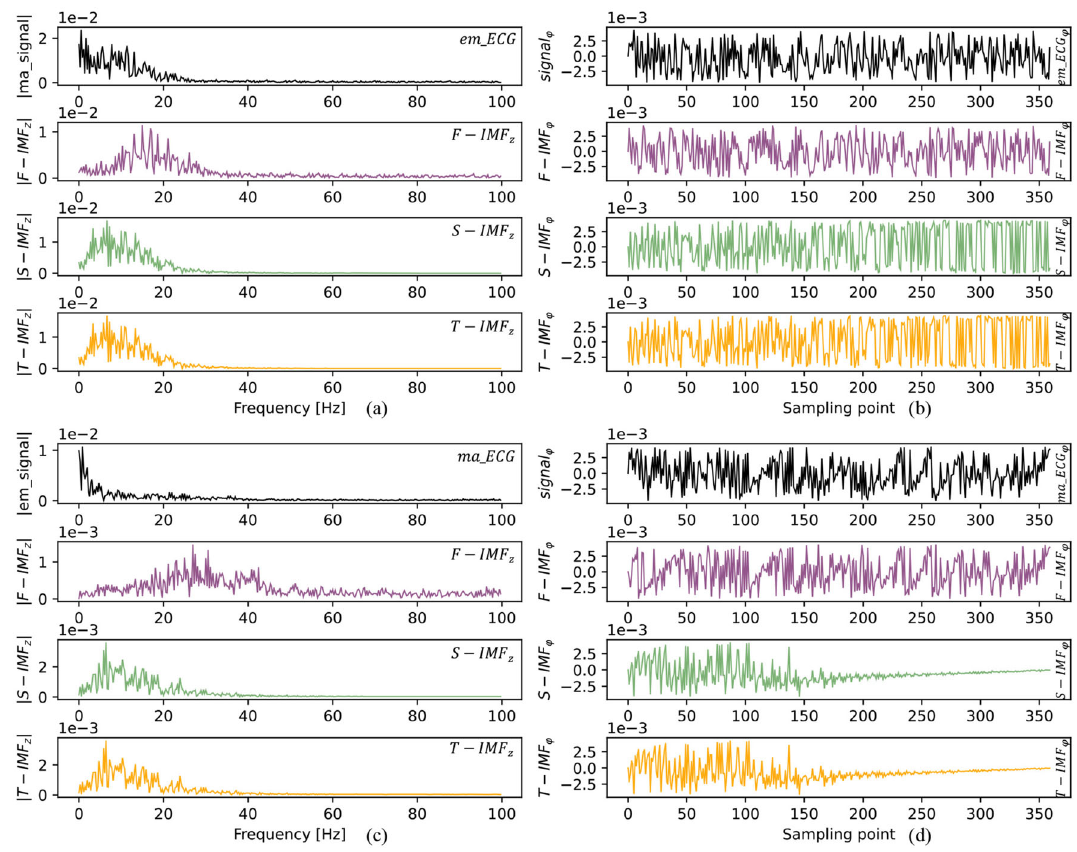
Fig. 4 A visualization display example of amplitude value and phase angle features of FT-IMF. a Amplitude-frequency features diagram of FT-IMF of the em-contaminated ECG. b Phase angle diagram of FT-